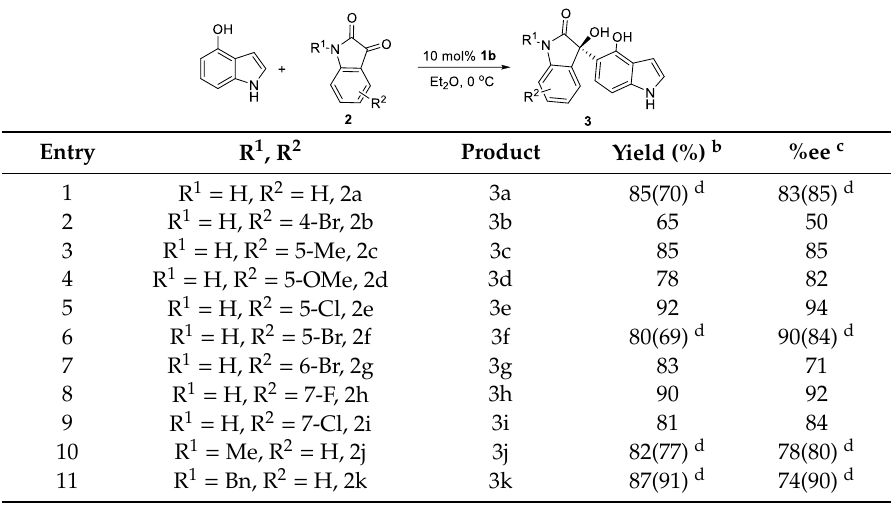
Table 3. Scope of the enantioselective hydroxyalkylation between 4-hydroxyindole and isatins a.